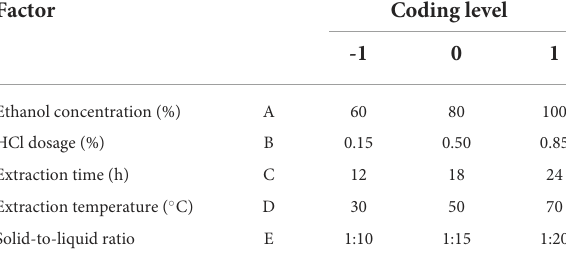
TABLE 1 Levels and codes of factors for Box-Behnken experimental design.